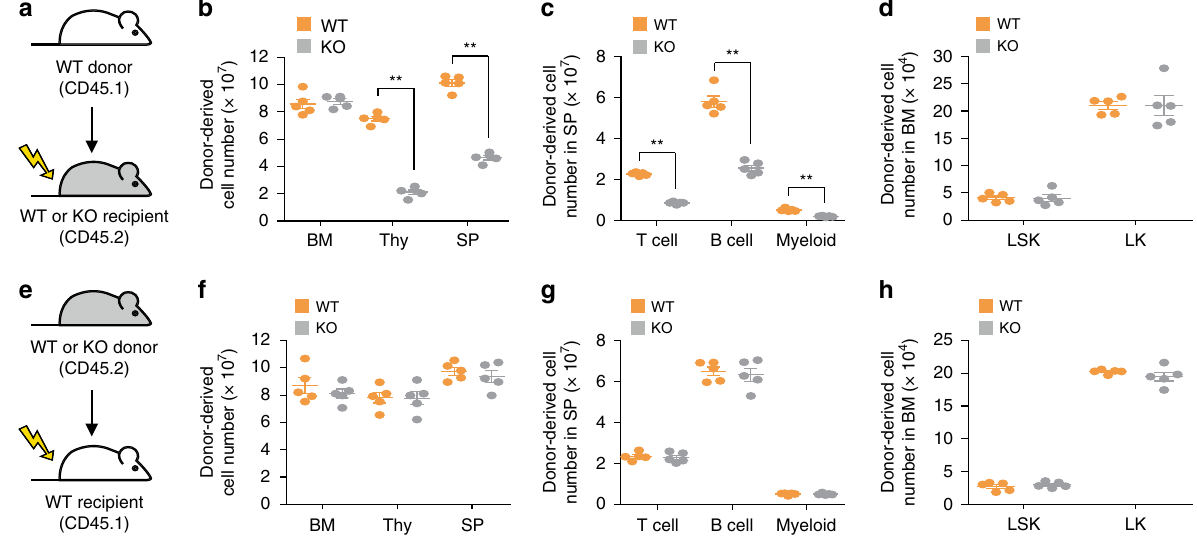
Fig. 3 An extrinsic factor from BMSCs is responsible for the impaired mobilization of KO HSPCs from the BM into the periphery. a – d Lethally irradiated WT and KO CD45.2 mice were transplanted with LSK cells from WT CD45.1 mice. n = 5 per group. a Schematic representation of LSK cell adoptive transfer. b Absolute number of donor-derived cells in the BM, thymus (Thy), and spleen (SP) of recipients. c Absolute number of donor-derived T cells, B cells, and myeloid cells (Myeloid) in the spleen of recipients. d Absolute number of donor-derived LSK cells (LSK) and LK cells (LK) in the BM of recipients. e – h Lethally irradiated WT CD45.1 mice were transplanted with LSK cells from WT or KO CD45.2 mice. n = 5 per group. e Schematic representation of LSK cell adoptive transfer. f Absolute numbers of donor-derived cells in the BM, Thy, and SP of recipients. g Absolute numbers of donor-derived T cells, B cells, and myeloid cells in the spleen of recipients. h Absolute numbers of donor-derived LSK and LK cells in the BM of recipients. Statistical signi fi cance was assessed by two-tailed Student ’ s t -test. ** P < 0.01. All data are presented as the mean ± SEM. Source data are provided as a Source Data